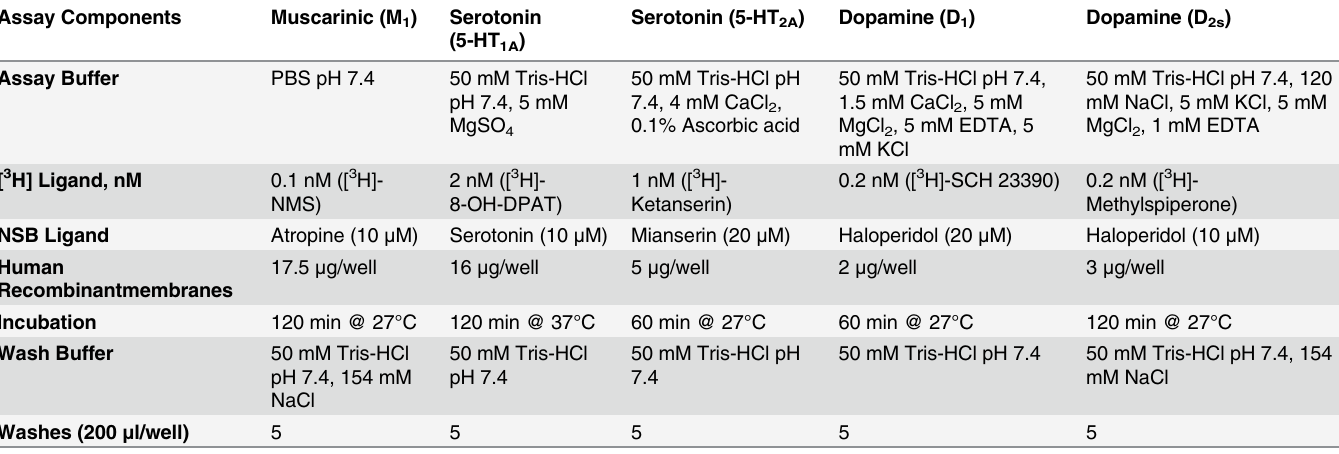
Table 1. Summary of radioligand receptor binding assay components and reactions according to each receptor.